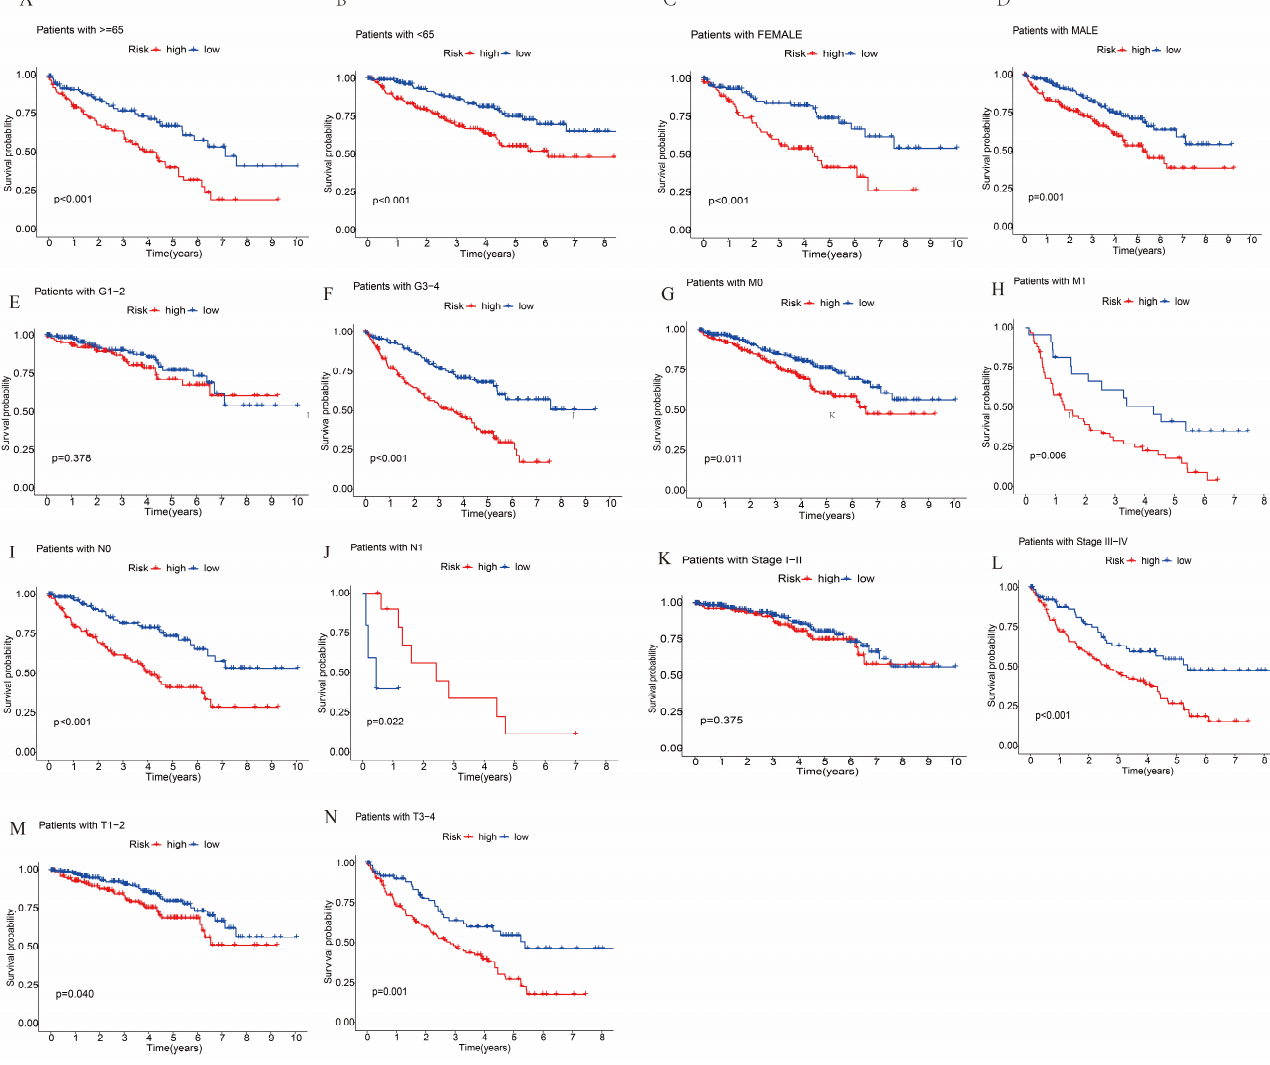
Figure 10. K‒M curves of different clinical variables between the high-risk and low-risk groups of ccRCC patients in TCGA. ( A ) K‒M curves for age ≥ 65 for the different risk groups of ccRCC patients. ( B ) K‒M curves for age < 65 years for the different risk groups of ccRCC patients. ( C ) K‒M curves for female for the different risk groups of ccRCC patients. ( D ) K‒M curves for male for the different risk groups of ccRCC patients. ( E ) K‒M curves for stages G1‒2 for the different risk groups of ccRCC patients. ( F ) K‒M curves for stages G3‒4 for the different risk groups of ccRCC patients. ( G ) K‒M curves for stage M0 for the different risk groups of ccRCC patients. ( H ) K‒M curves for stage M1 for the different risk groups of ccRCC patients. ( I ) K‒M curves for stage N0 for the different risk groups of ccRCC patients. ( J ) K‒M curves for stage N1 for the different risk groups of ccRCC patients. ( K ) K‒M curves for stages I‒II for the different risk groups of ccRCC patients. ( L ) K‒M curves for stages III‒IV for the different risk groups of ccRCC patients. ( M ) K‒M curves for stages T1‒2 for the different risk groups of ccRCC patients. ( N ) K‒M curves for stages T3‒4 for the different risk groups of ccRCC patients.